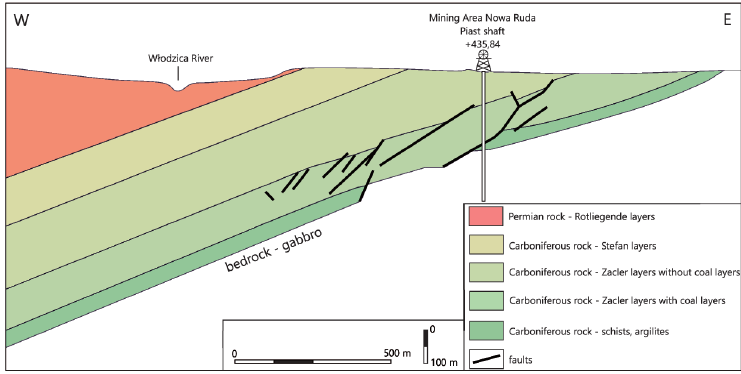
Figure 5. Geological cross-section through the Nowa Ruda